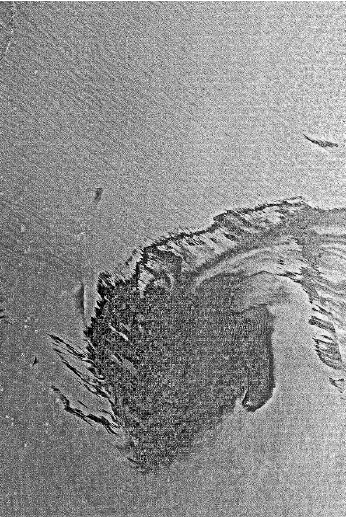
Figure 10. RADARSAT-2 view of a small portion of the Gulf oil spill. This is detail from another wide-field image to show the detail that radar is capable of. The white dots are ships working on well control. (Image from Canadian Space Agency website http://www.asc-csa.gc.ca/images).